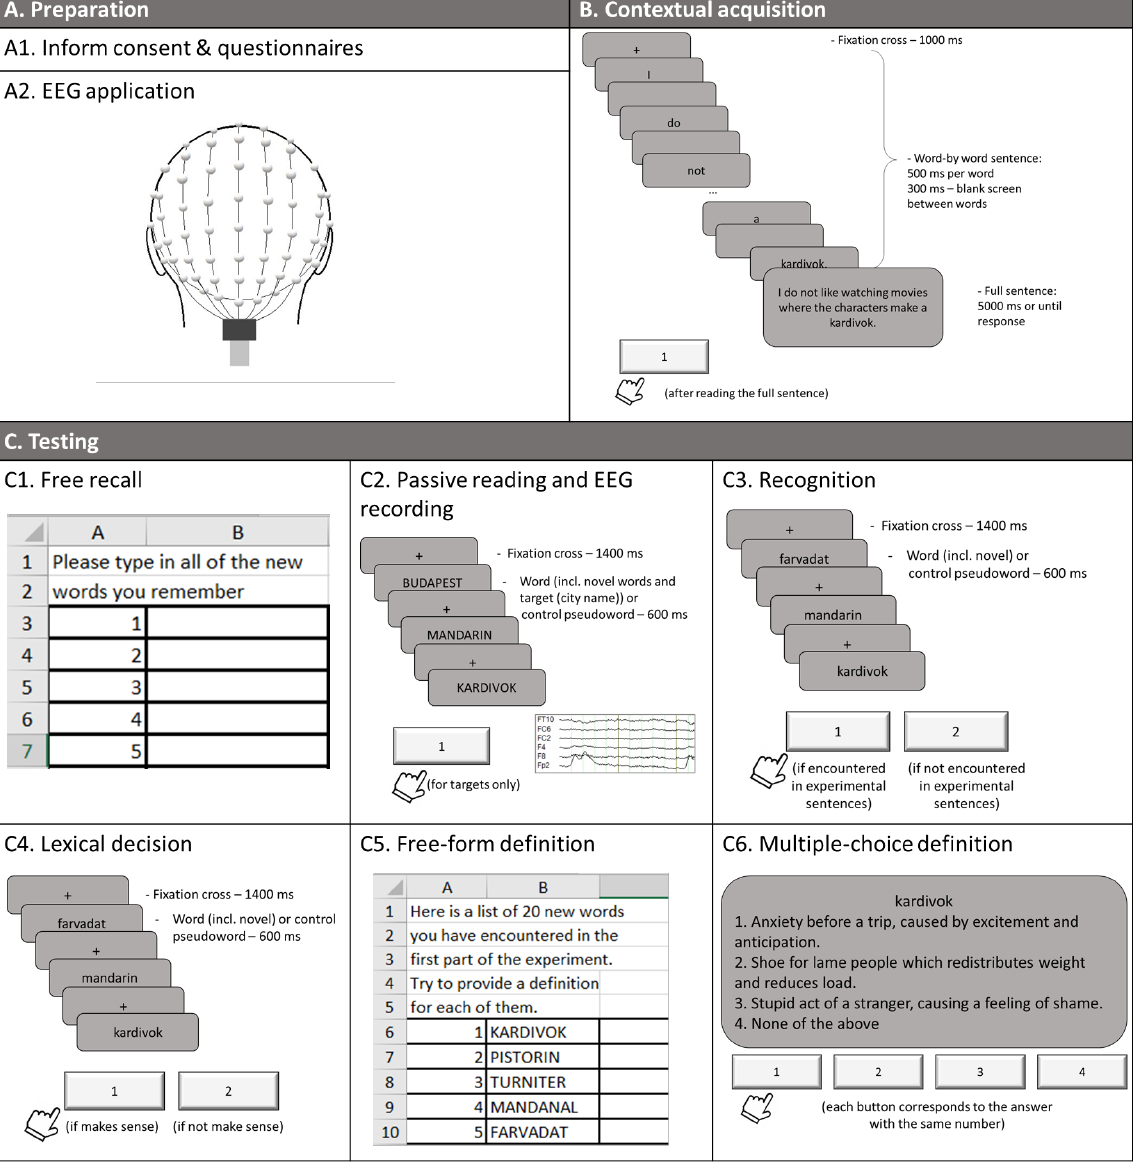
Figure 1. Experimental procedures.